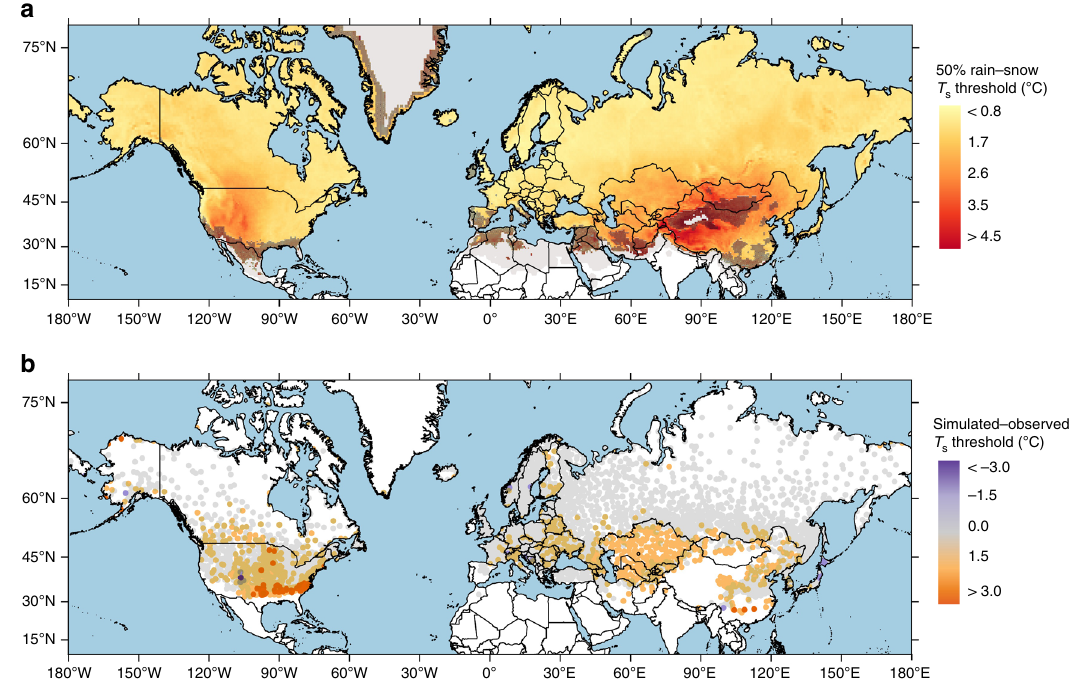
Fig. 3 The simulated 50% rain – snow T s threshold across the Northern Hemisphere and the difference between simulated and observed thresholds. a The simulated 50% rain – snow T s threshold is computed using a hyperbolic tangent fi t to simulations of precipitation phase using a binary logistic regression model applied to gridded MERRA-2 reanalysis data (see Methods). Hatching indicates there were not enough data to compute the threshold using a hyperbolic tangent and the resultant threshold was calculated using a linear regression based on snow probability between 0.5 and 6.5 °C. Areas shaded in gray had some modeled snowfall, but there were not enough total events and/or snowfall days per temperature bin in order to identify a 50% rain – snow T s threshold using either method. Note that this may occur for regions that are typically cold (e.g., central Greenland) or warm (e.g., northern Africa). Areas with no shading did not have any modeled snowfall in the − 8 to 8 °C temperature range. b Differences between the simulated and observed 50% rain – snow T s thresholds. Gray shading indicates differences were within ±1 °C (81.0% of